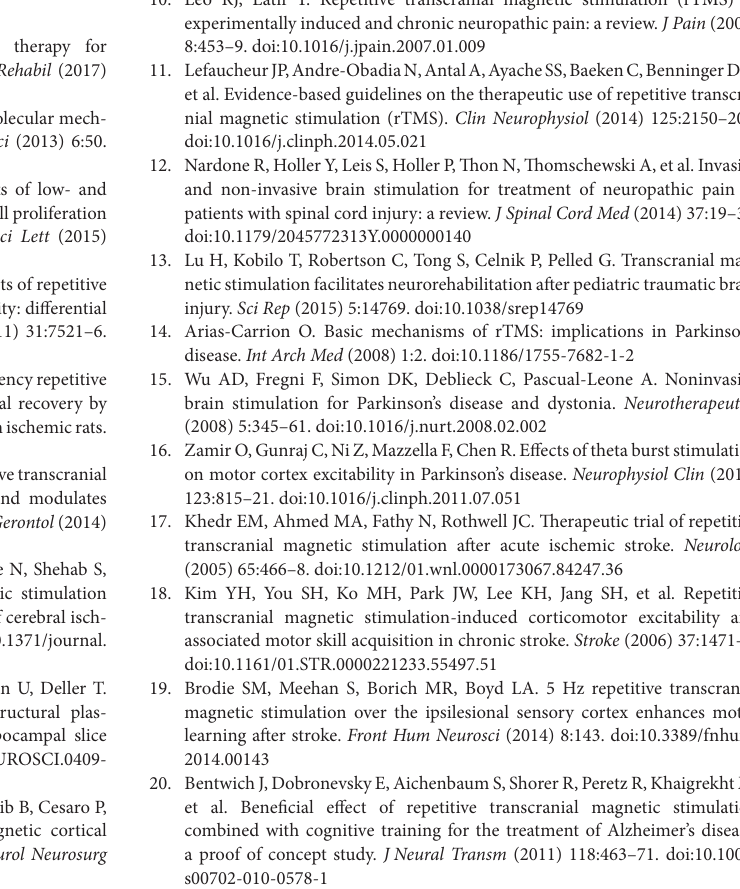
TaBle s1 | Raw data for 21,567 differentially expressed transcripts. TaBle s2 | Raw data for 798 differentially expressed